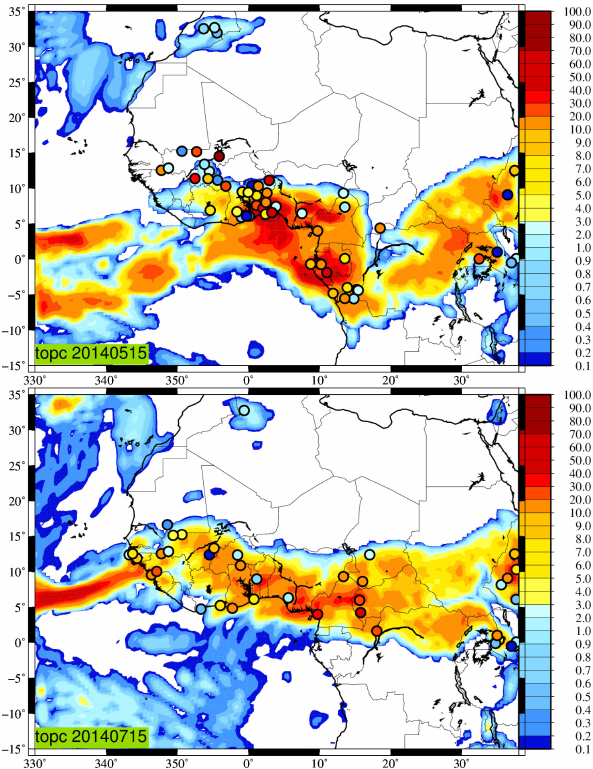
Figure C1. Comparison between observed and modelled daily cumulated precipitation rate (mmday − 1 ) for 15 May and 15 July 2014. For the precipitation measurements, only the non- zero daily cumulated values are reported on the